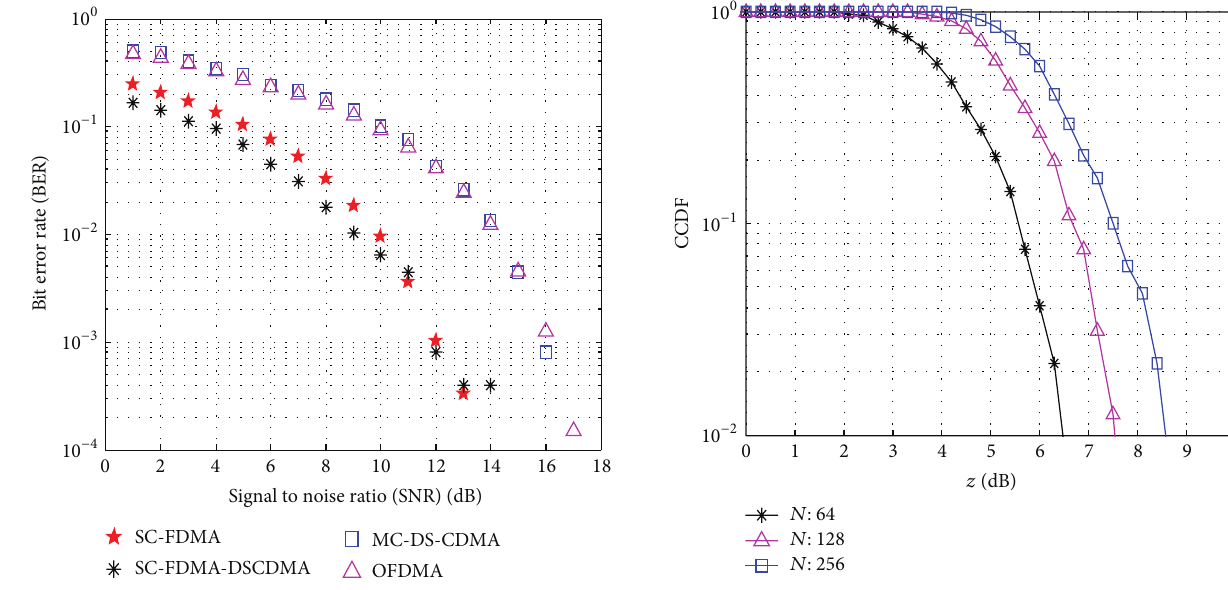
Figure 4: BER performance of the proposed SC-FDMA-DSCDMA techniquecomparedwithothermulticarriertechniques(overRician channel). BER performance of the proposed technique is again best and very close to that of SC-FDMA. No degradation due to modified technique.